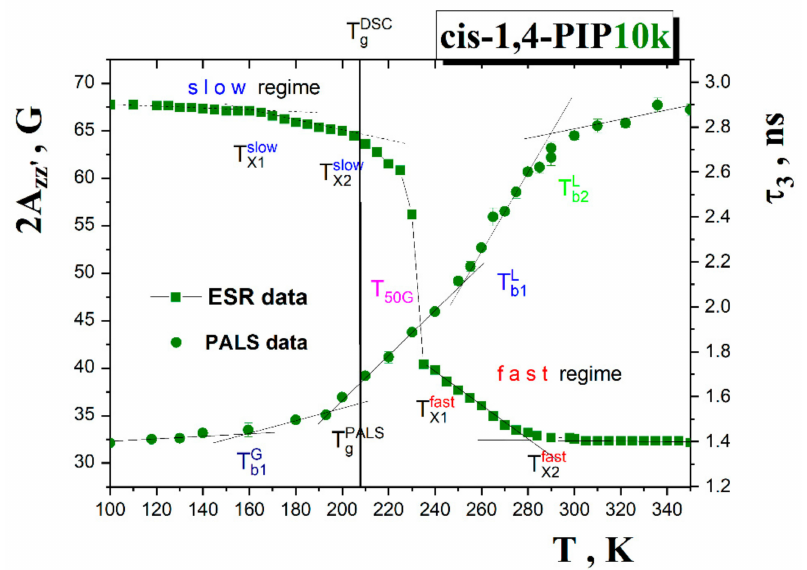
Figure 11. Comparison of spectral parameter of mobility, 2 A zz (cid:48) , with the ortho -positronium ( o -Ps) lifetime, τ 3 , as measures of the spin probe TEMPO mobility or the local free volume,